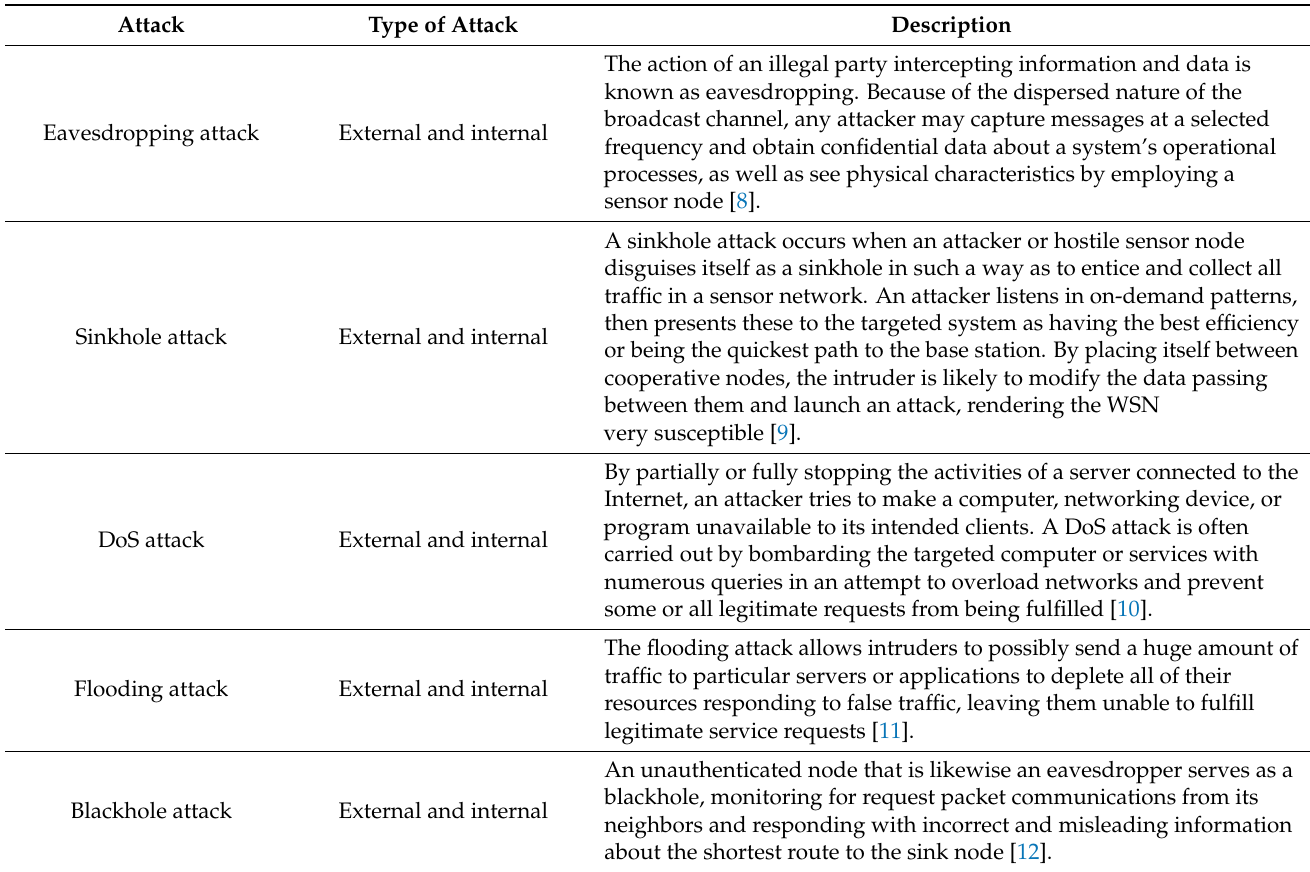
Table 1. Types of attacks in a wireless sensor